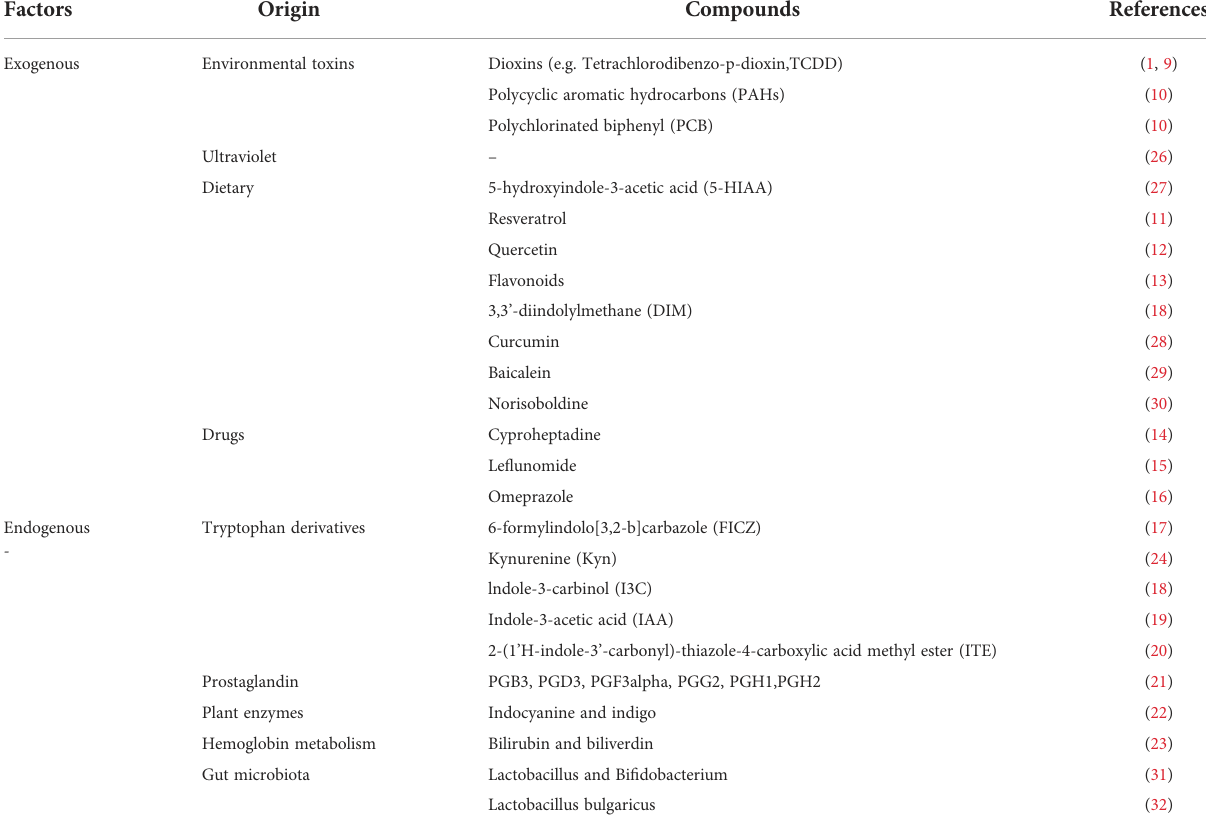
TABLE 1 Endogenous and exogenous factors that can affect AhR.